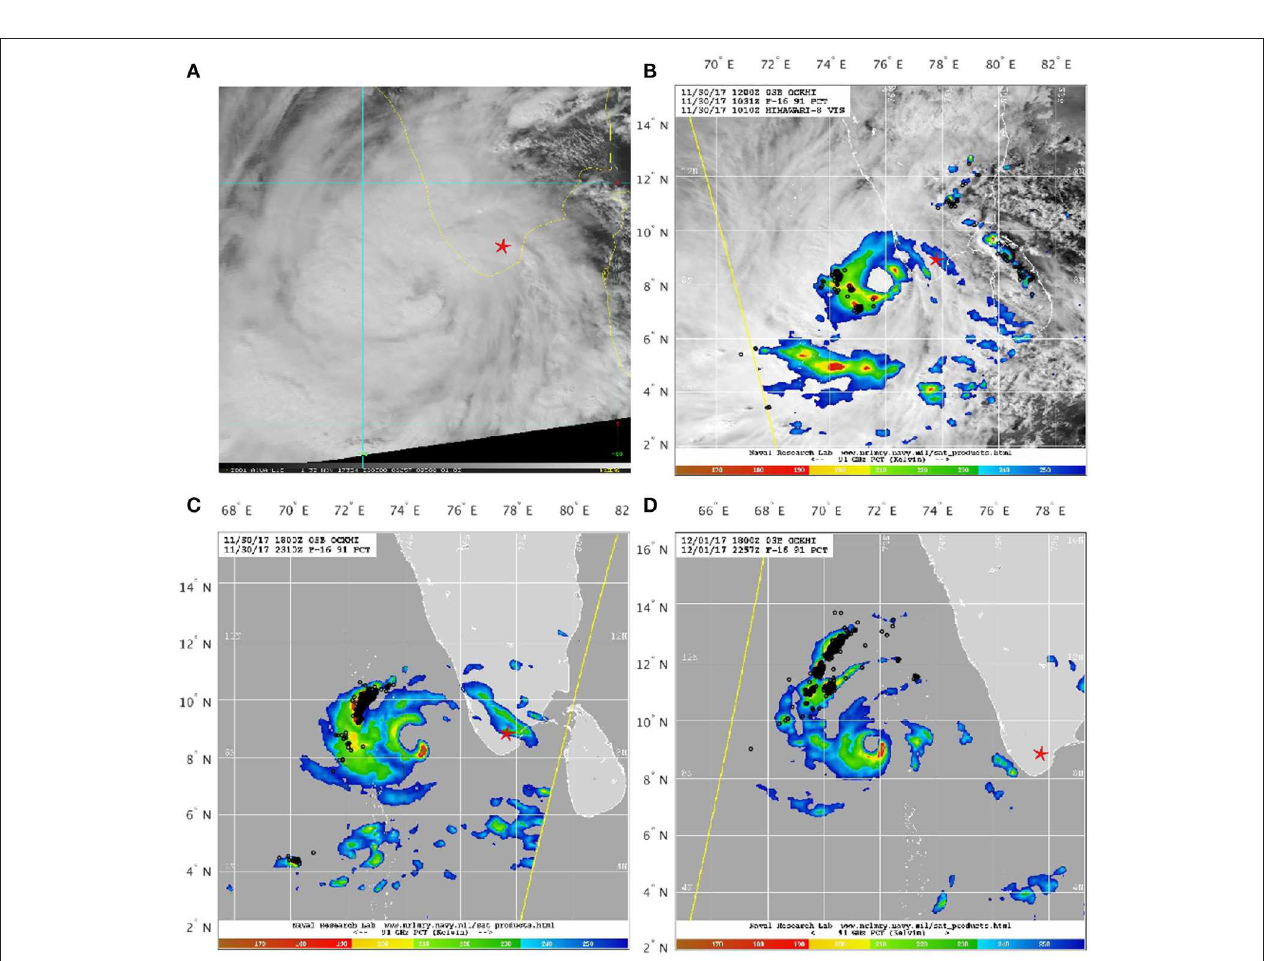
FIGURE 4 | (A) Visible imagery in natural color on 30 November at 08:05 UT (Courtesy : NOAA Satellites and Information); (B–D) Satellite images from the Naval Research Lab overlaid with lightning strokes (shown as black circles) during ± 15 min of satellite image time. The color contour shows the water vapor content. Image (B) is taken on 30 Nov, 10:31 UT; image (C) on 30 Nov, 18:00 UT; image (D) on 1 Dec, 18:00 UT (Courtesy: WWLLN); In all sub-images, a red star shows the location of the observation site, Tirunelveli.